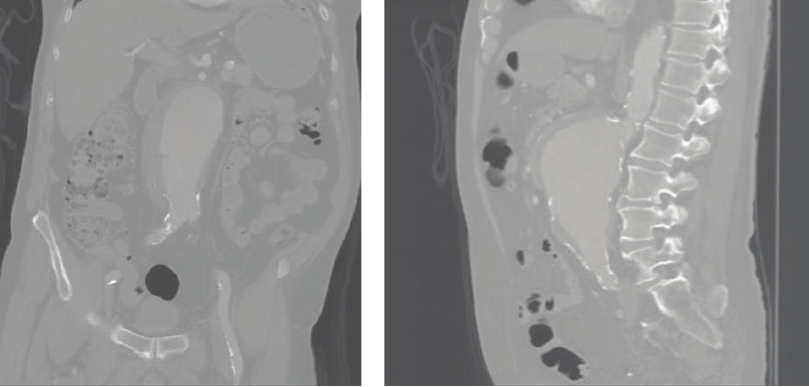
Figure 1: Juxtarenal AAA on CT scan.